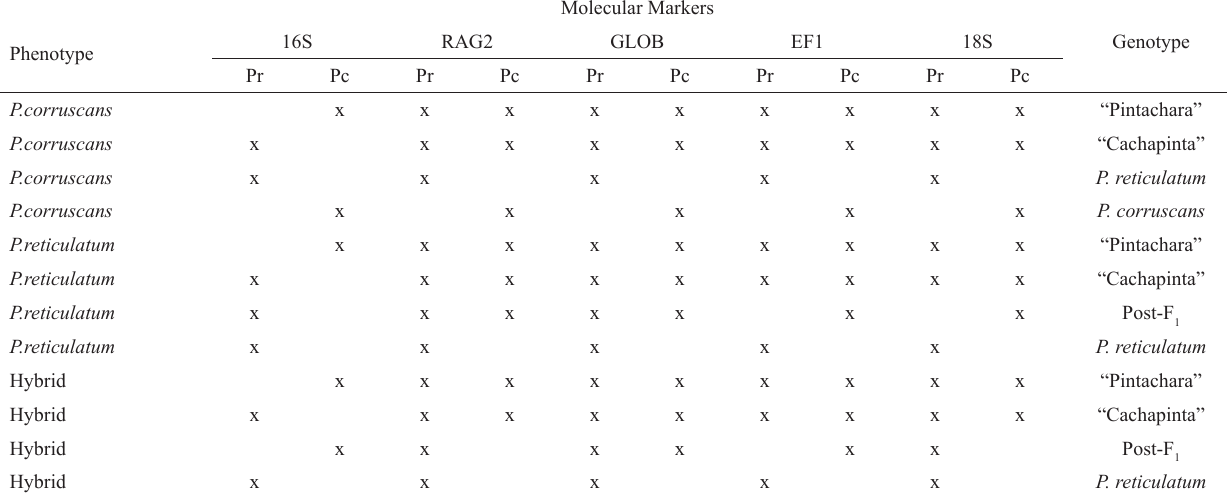
Table 4. Examples of phenotypic and genotypic characterization resulting from the analyses. Pc= Pseudoplatystoma corruscans ; Pr= Pseudoplatystoma reticulatum